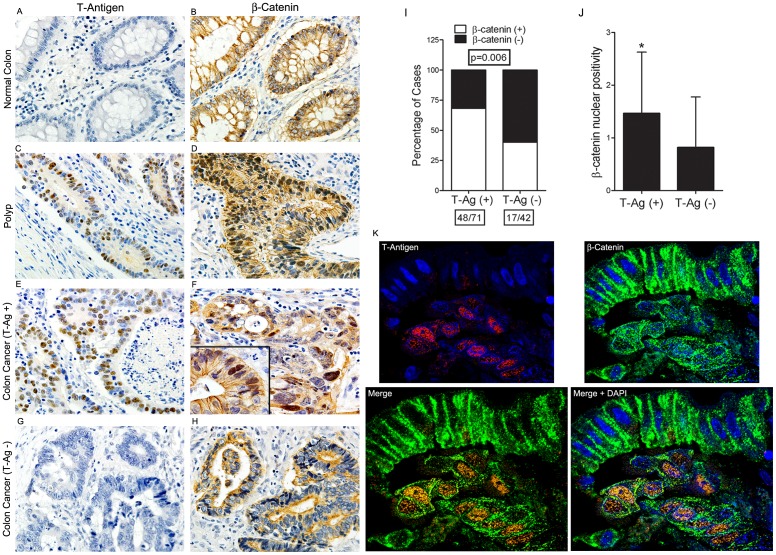
T-Antigen and β-catenin expression in colon cancer cases.Immunohistochemistry in areas of normal colonic epithelium is negative for T-Antigen, while β-catenin is expressed in the cytoplasm and membrane (Panels and B). T-Antigen expression is found in the nuclei of epithelial cells in polyps and neoplastic cells in areas of invasive tumor (Panels C and E, respectively). Consecutive sections of the same cases show that β-catenin is now located to the cytoplasm and nuclei of epithelial and tumor cells (Panels D and F respectively). In T-Antigen negative cases however, β-catenin remains in the cytoplasm (Panels G and H). Statistical analysis reveals that 67.6% of T-Antigen positive colon cancer cases express nuclear β-catenin, while only 40.4% of T-Antigen negative cases express nuclear β-catenin (G; p = 0.006) (Panel I). The relative percentage of nuclei positive for β-catenin in a section was scored on a scale of 0–4. T-Antigen positive cases showed significantly more nuclei positive for β-catenin than T-Antigen negative samples (F; *p<0.05) (Panel J). Double labeling immunofluorescence demonstrates the co-localization of T-Antigen (Rhodamine) and β-catenin (Fluorescein) in the nuclei of neoplastic cells in a pocket of neoplastic cells underneath an epithelial lining of T-Antigen negative cells, in which β-catenin remains cytoplamic (Panel K). Original magnification of all immunohistochemistry panels is 600x, and immunofluorescence is 1000x.